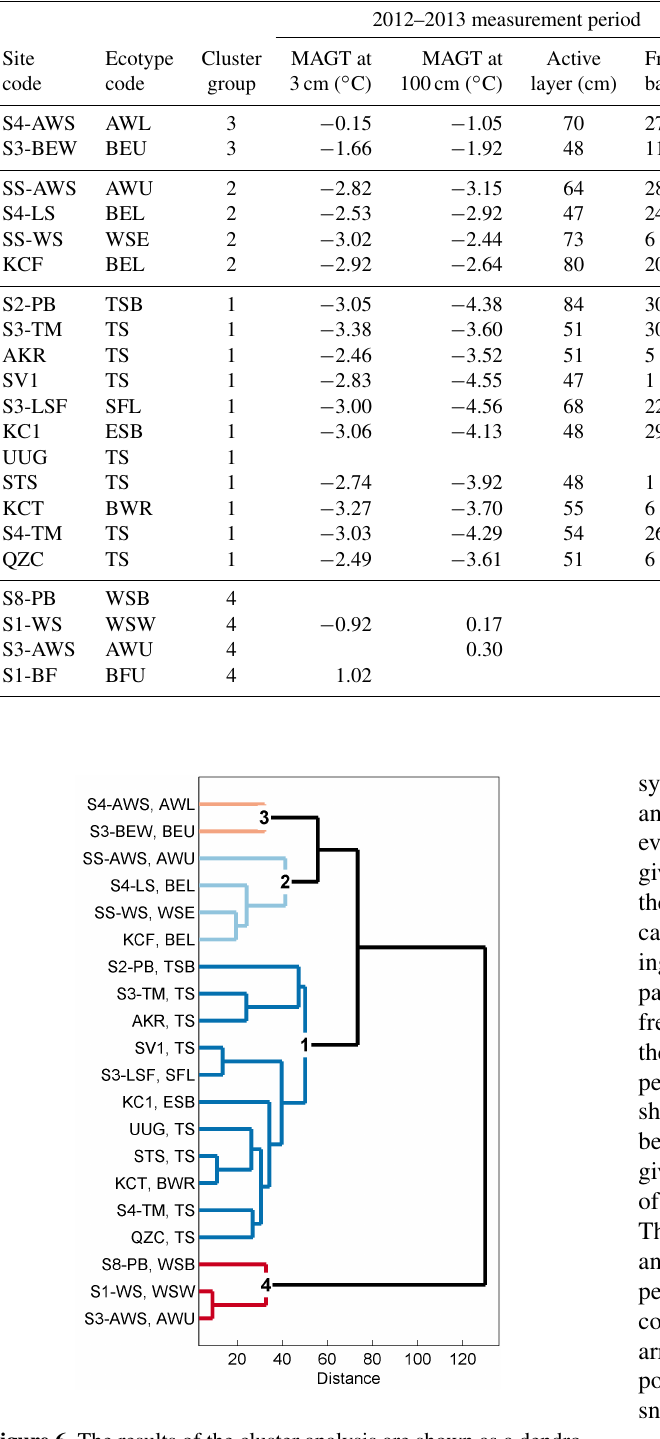
Figure 6. The results of the cluster analysis are shown as a dendro-